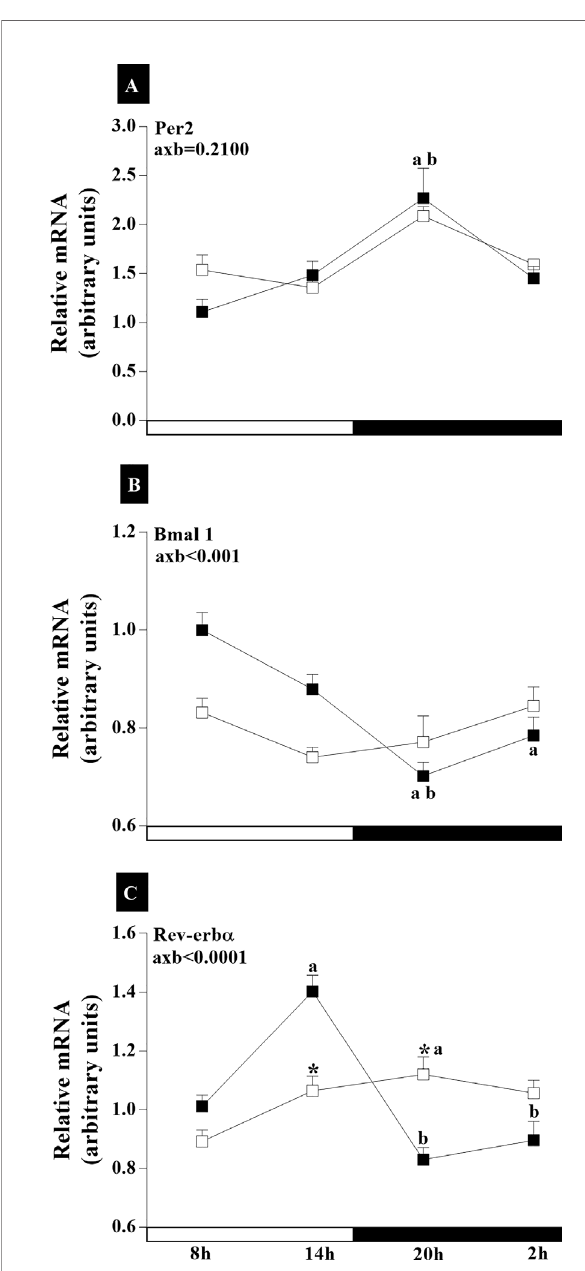
FIGURE 4 | Daily oscillations in relative mRNA expression for Per2 , Bmal1 , and Rev-erb a in the suprachiasmatic nucleus. Light and dark phases are represented along the X-axis by their respective schedules. Beginning of the light phase at 07:00, when the lights are turned on. The dark phase started at 19:00. All samples were collected at six-hour intervals after the fi rst hour (i.e., 08:00), for 24 h. Light/dark cycle = 12/12 h. (A) Relative temporal expression of mRNA for Per2 , (B) Bmal1 , and (C) Rev-erb a in animals with a regular cycle on diestrus day and irregular cycle in persistent diestrus. * indicates intergroup variation at the same time: ( ■ ) Regular estrous cycle on diestrus day × ( □ ) irregular cycle in persistent diestrus. Letters indicate temporal variation within the group. a vs. 8:00; b vs. 14:00, and c vs. 20:00. axb = age and time of day interaction. n = 3 – 7. Replicates with a variation above 0.2 were automatically excluded from the groups. DD Ct for Per2 and Rev-erb a ; relative standard curve for Bmal1 .